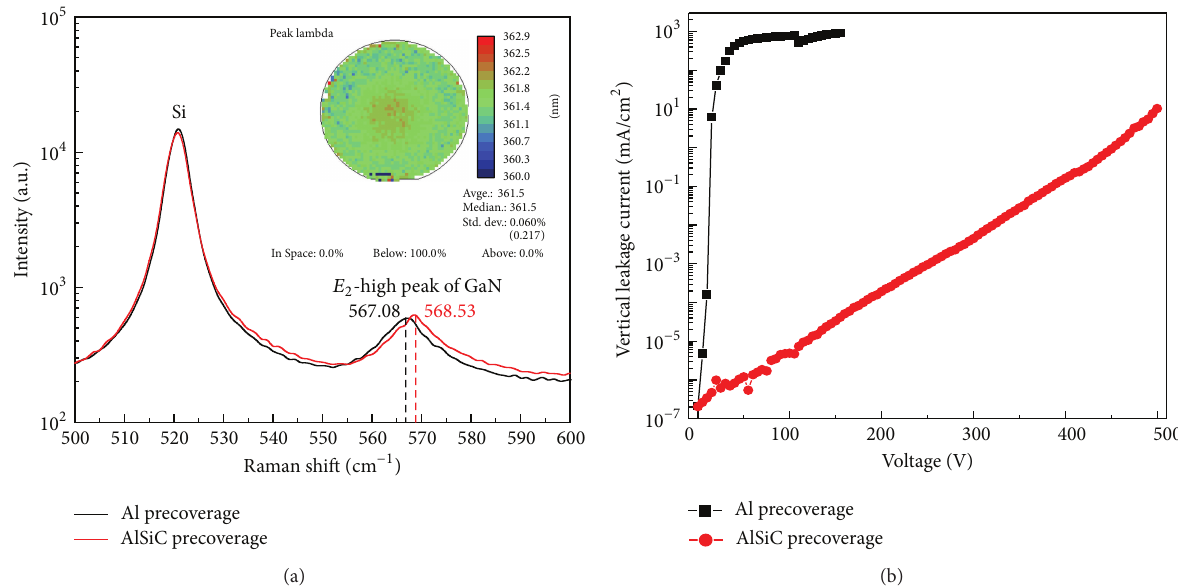
Figure 4: (a) Raman scattering spectra of AlGaN/GaN layers grown on Si substrate with Al and AlSiC precoverage layer. The inset shows the map image of wavelength for grown films with AlSiC precoverage layer. (b) Vertical leakage current of AlGaN/GaN layers grown on Si substrate with Al and AlSiC precoverage layer.